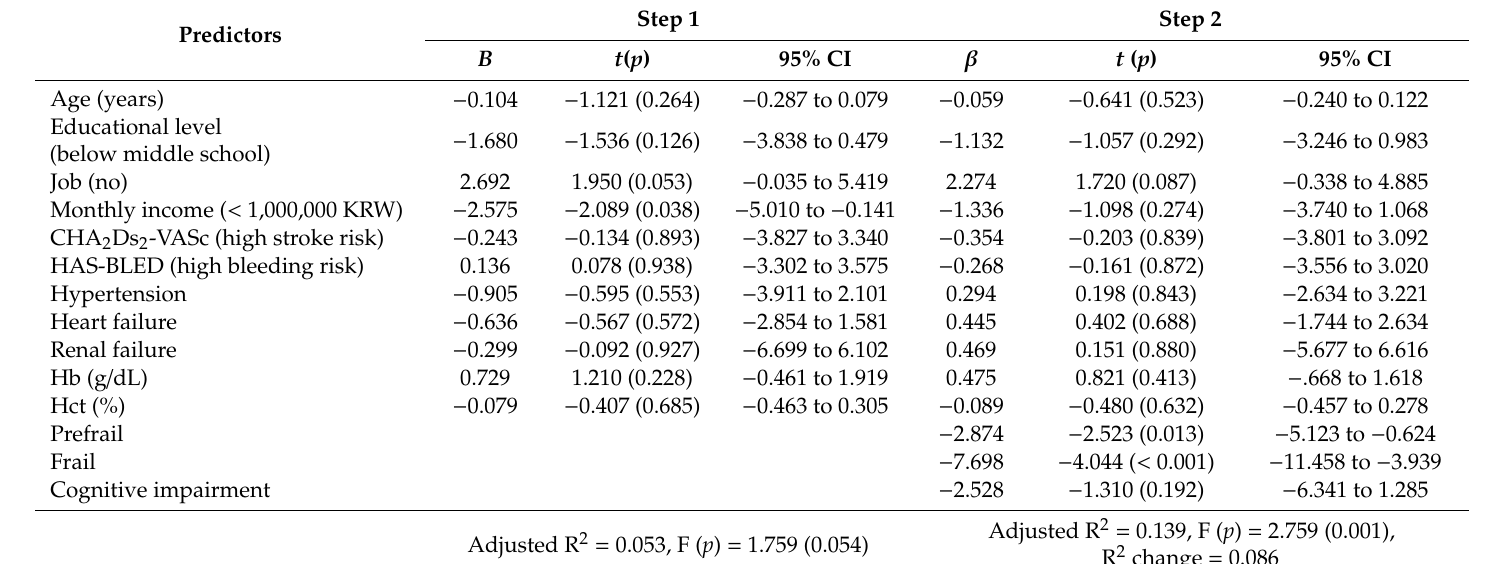
Table 4. Hierarchical linear regression analysis of self-care behaviors in male patients with AF ( n =